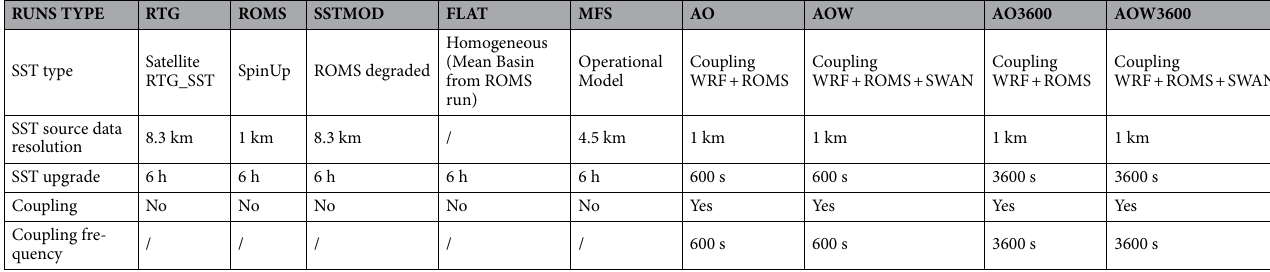
Table 1. The table summarizes the types of runs proposed and the approaches followed in terms of type of Sea Surface Temperature, resolution of the SST data, updating of the SST data and coupling.